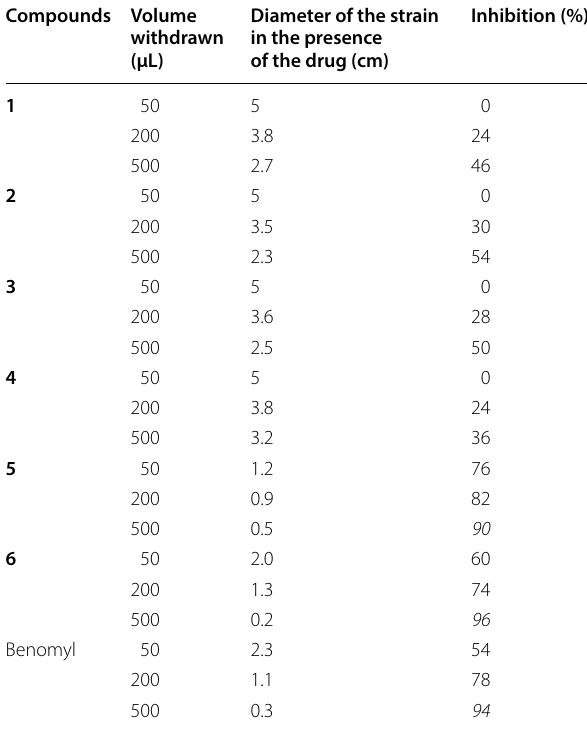
Table 5 Values of antifungal activity of the pyrazole-keto enol compounds against Fusarium oxysporum